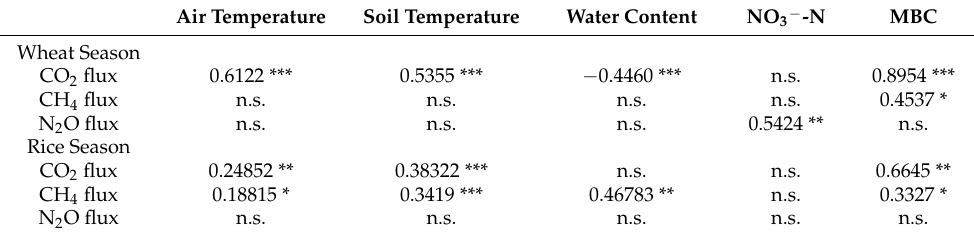
Table 4. Correlation coefficients (r) for simple correlation analysis between GHGs emissions and environmental factors under different fertilizer